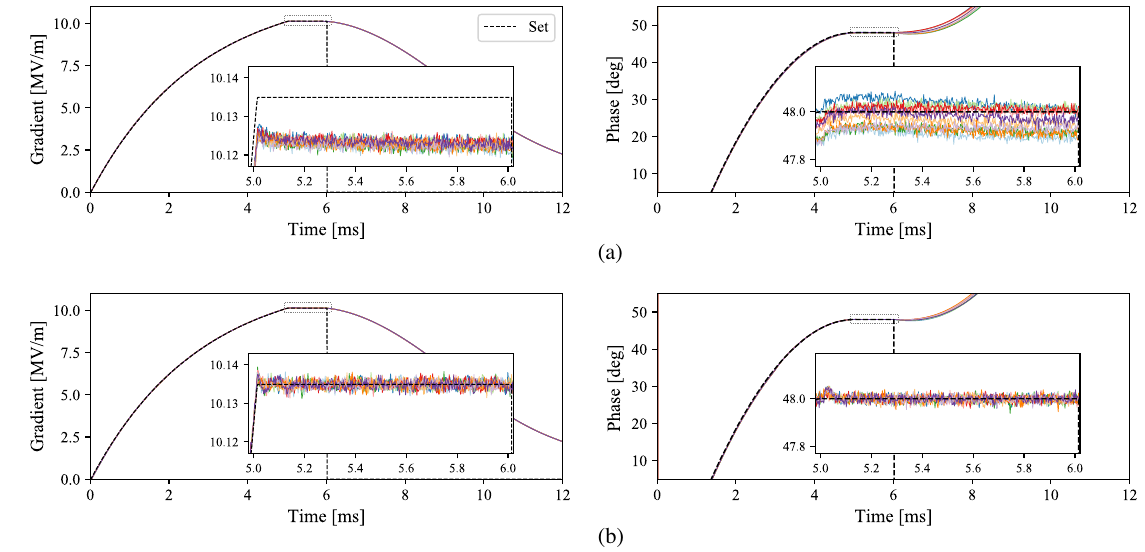
FIG. 19. Amplitude (left) and phase (right) stability in ML2 ( V c ¼ 10 . 5 MV) in the case of (a): P control and (b): P þ DOB control in the absence of the beam. This figure shows 10 randomly selected pulses from the data during one hour.